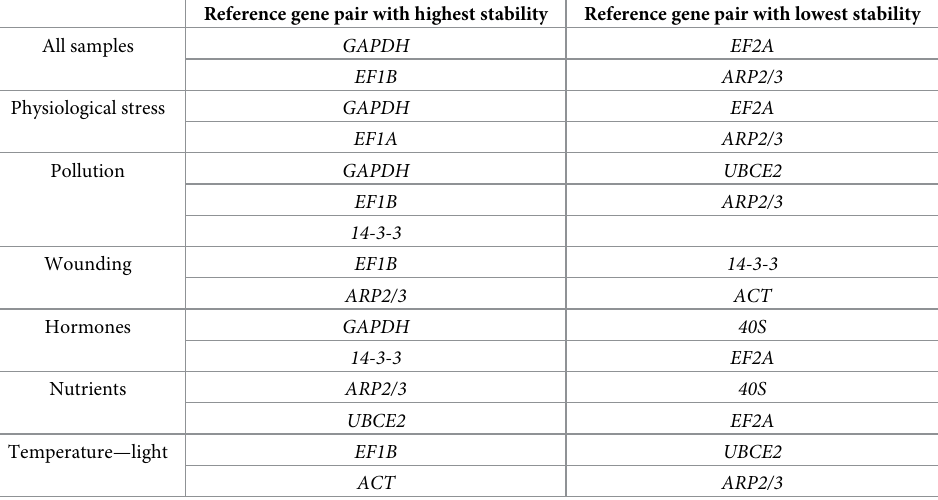
Table 2. List of recommended reference genes for each of the tested